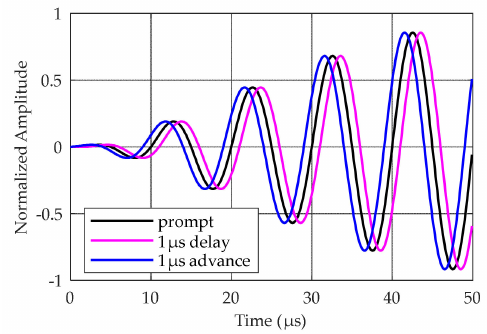
Figure 2. Pulse position modulation (PPM)